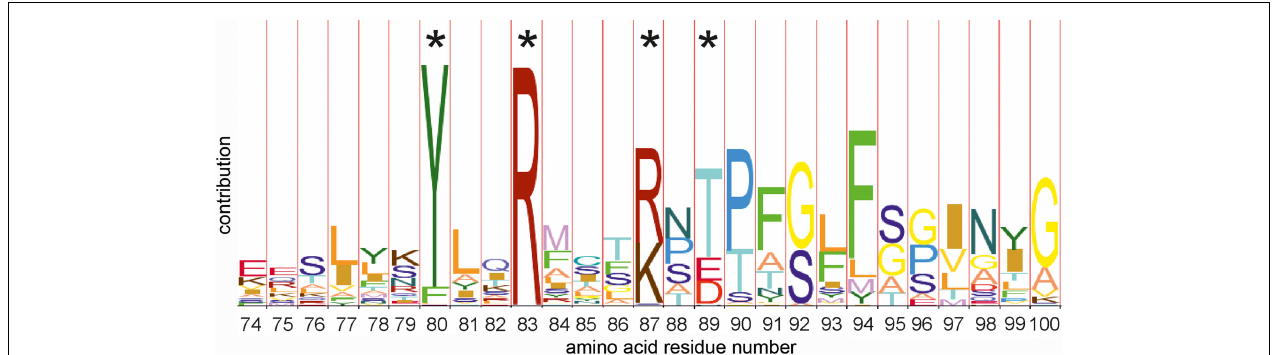
FIGURE 2 | HMM-logo of the N-terminal amino acid alignment of thirty six members of the dehydratase LanB family. The hidden markov model (HMM) shows a number of conserved amino acid residues. Residues marked with an asterisk have been (among others)